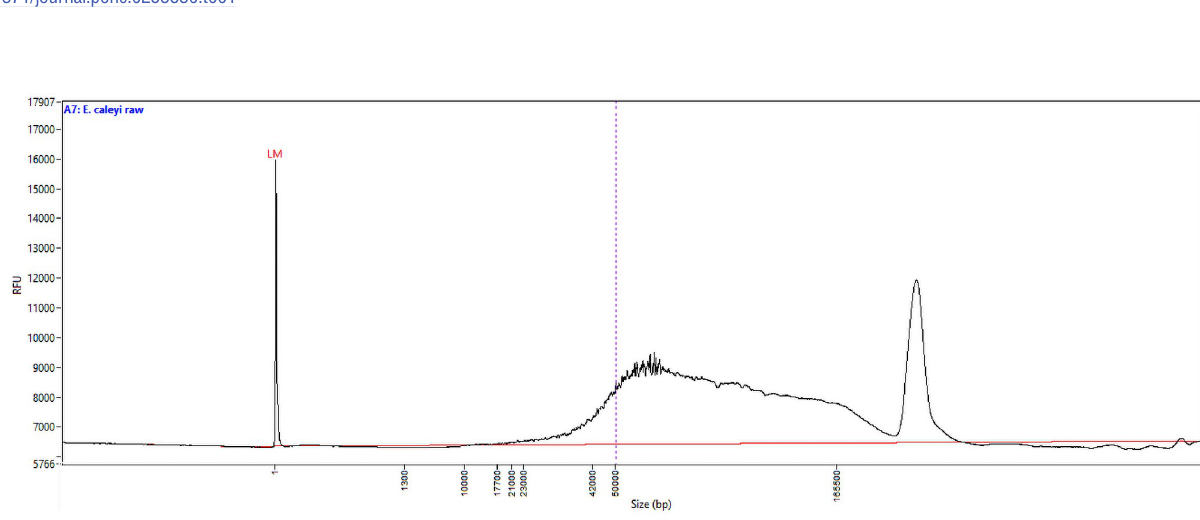
Fig 1. DNA size distribution of Eucalyptus caleyi based on a pulsed-field capillary electrophoresis system, a Femto Pulse (Agilent). Peak at 200 kb represents all fragments > 200 kb, as they cannot be resolved with the technology. Sample was crude DNA prior to and size selection or further DNA clean-up.